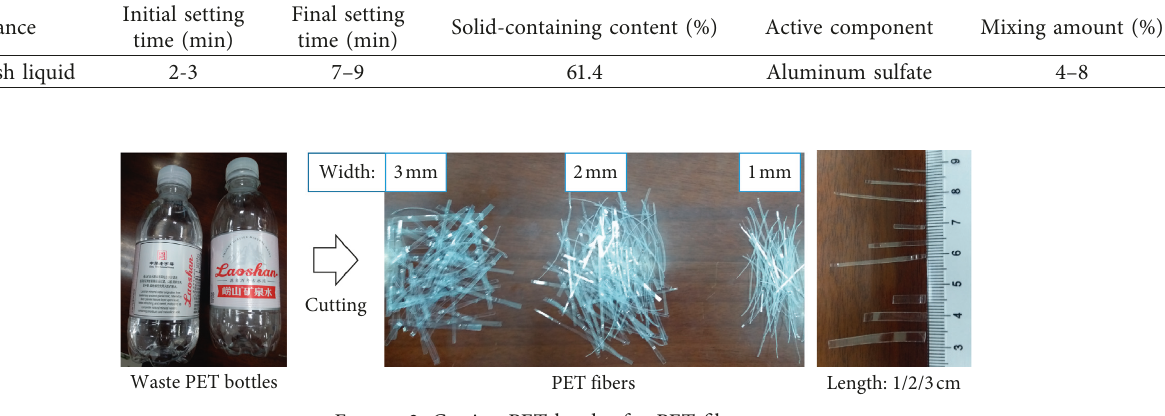
Figure 2: Cutting PET bottles for PET fibers. Table 2: Mix proportion of wet-mix shotcrete (kg/m 3 ).